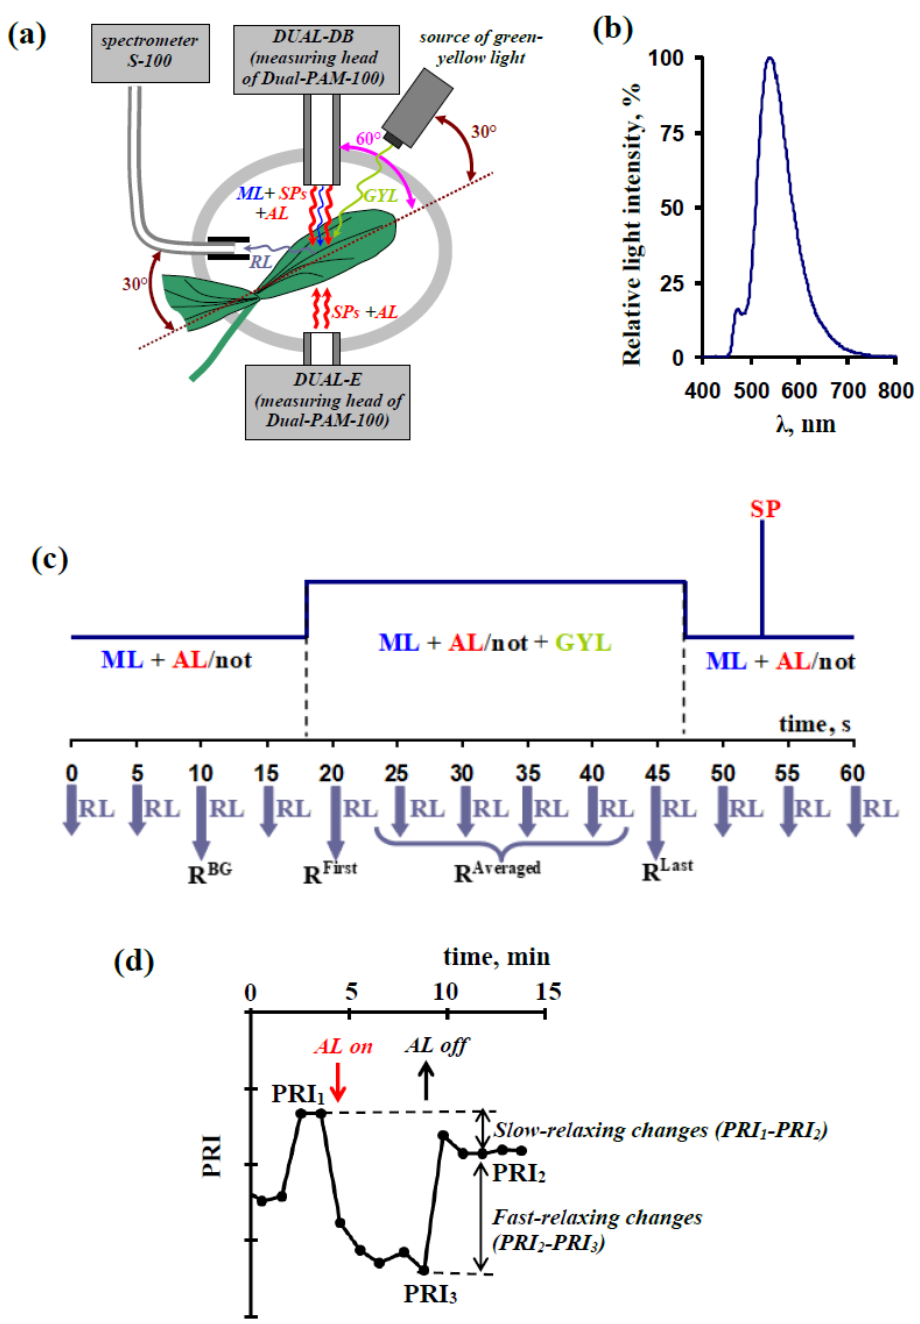
Figure 1. ( a ) A schema of the measurements of the reflected light (RL), the photosystem II (PSII) fluorescence, and the photosystem I (PSI) light absorption in pea leaves. ML was the weak measuring light, AL was the red actinic light, GYL were the pulses of the measuring green-yellow light, and SPs were the pulses of saturation red light. ( b ) A light spectrum of the green-yellow light source. ( c ) A schema of the measurement of the intensities of the reflected light (R) at the investigated wavelengths of the GYL pulse. R BG and R Averaged were the reflected light intensity before the GYL pulse and the averaged reflected light intensity during this pulse, excluding the first (R First ) and the last (R Last ) values. ( d ) A scheme of the calculation of the fast- and slow-relaxing components of a photochemical reflectance index (PRI). AL on and AL o ff were the initiation and termination of the illumination by actinic light,